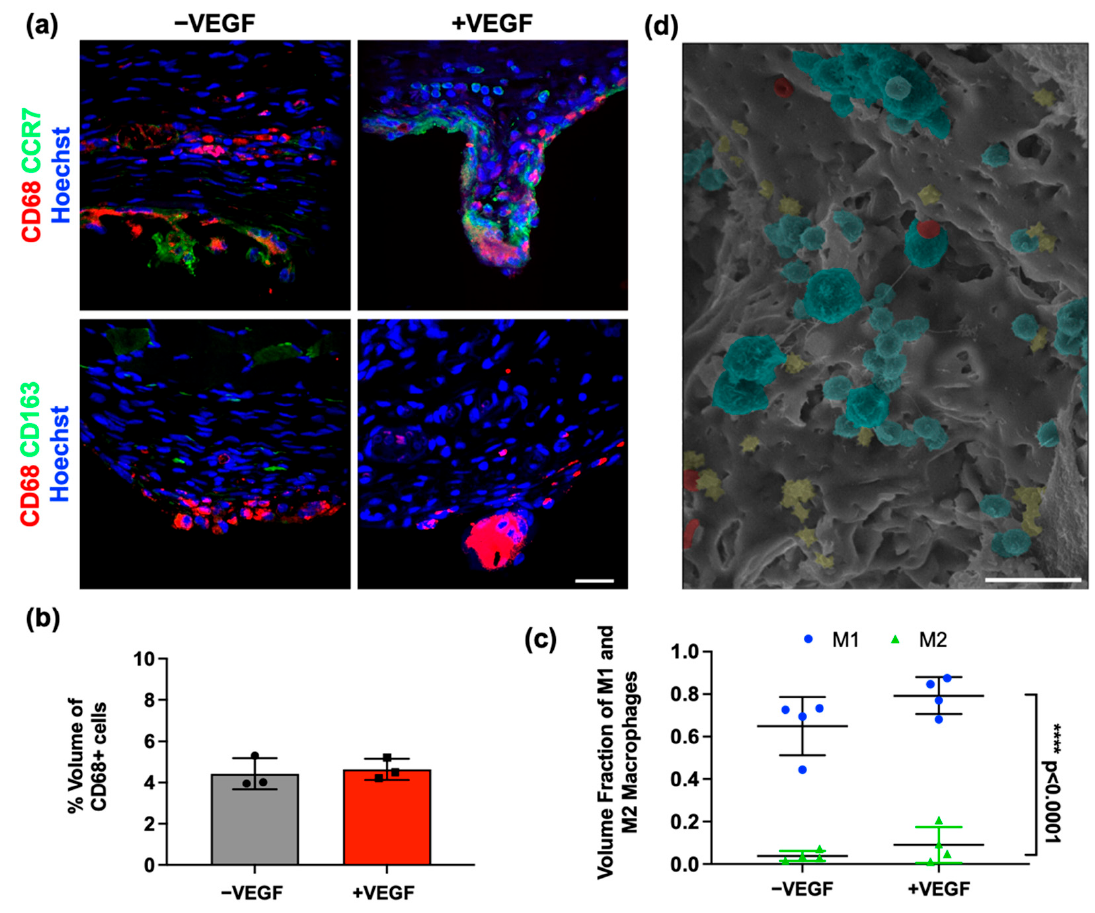
Figure 5. VEGF does not cause a heightened inflammatory response. ( a ) Representative images of CD68 and CCR7 (M1 ‐ like) phenotype marker (Hoechst, blue; CCR7, green; CD68, red) and CD68 and CD163 (M2-like) phenotype marker (Hoechst, blue; CD163, green; CD68, red) for both treatment groups. Scale bar = 20 µ m. ( b ) Percentage volume of CD68+ (pan ‐ macrophage marker) cells. ( c ) Percentage volume of CCR7+ and CD163+ macrophages. ( d ) SEM image demonstrating an aggregation of cells on the diffusion membrane of the device (macrophages, blue; erythrocytes, red, lymphocytes, yellow). Scale bar = 50 µ m. n = 4 per group, data are represented as means ± SD, M1 vs. M2 **** p <